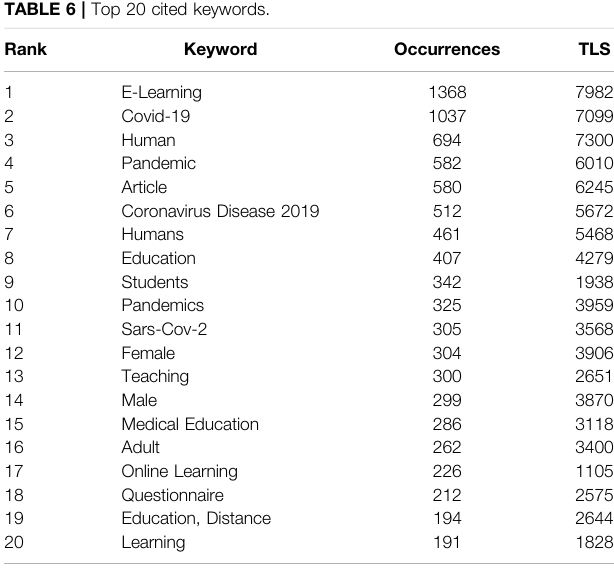
Frontiers in Environmental Science |